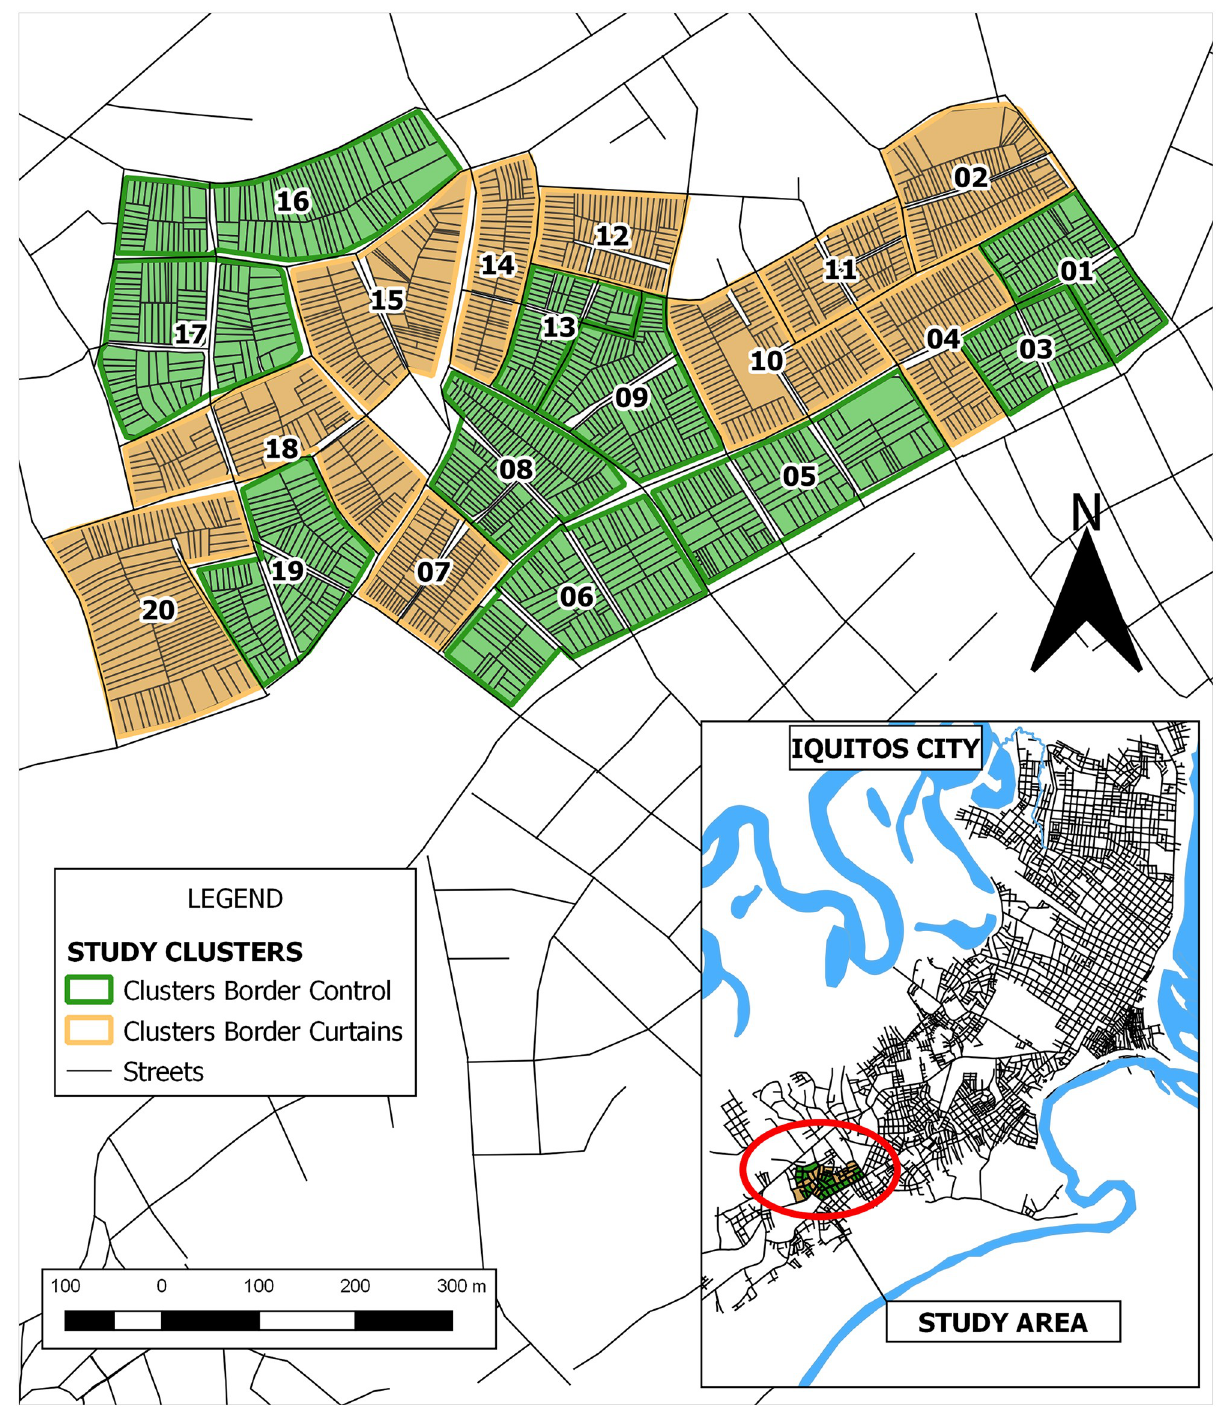
Fig 2. Map of the study area showing the location of the twenty clusters, randomized to either receive ITCs or act as an untreated control (no ITCs). This figure was created using QGIS software using shapefiles created as described previously [32, 33].